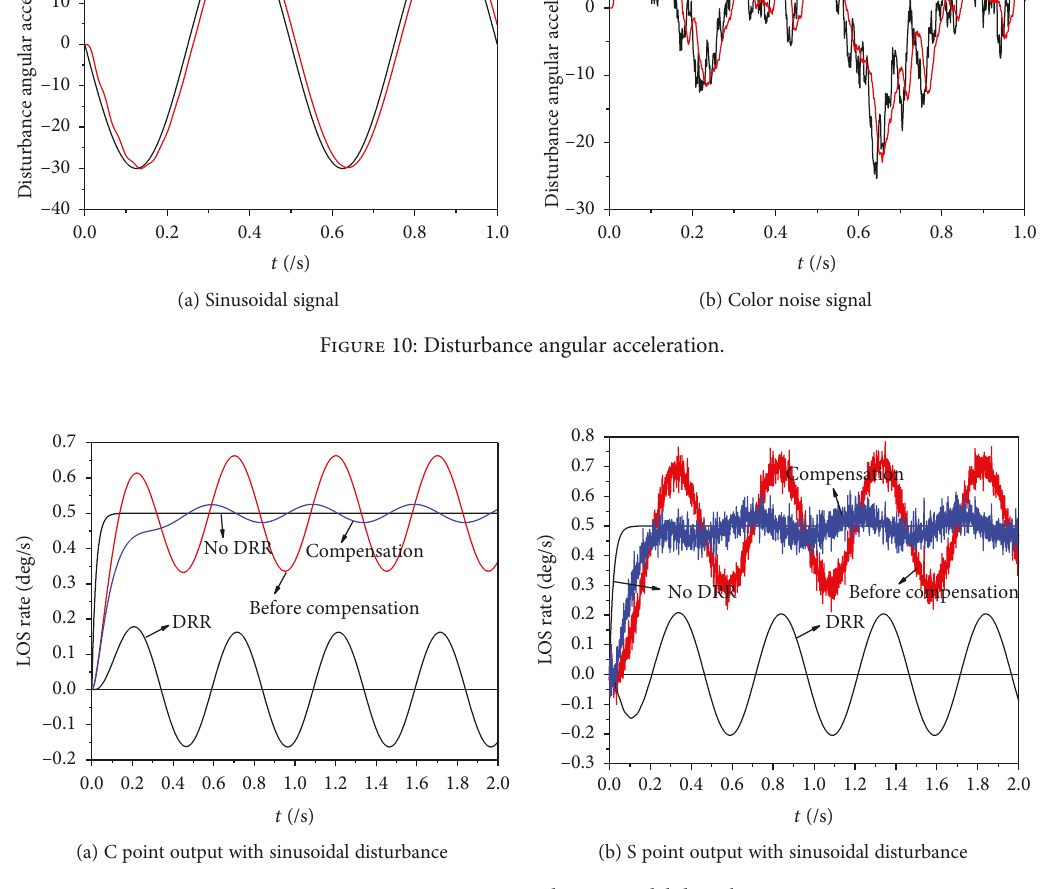
Figure 11: LOS rate outputs under sinusoidal disturbance.